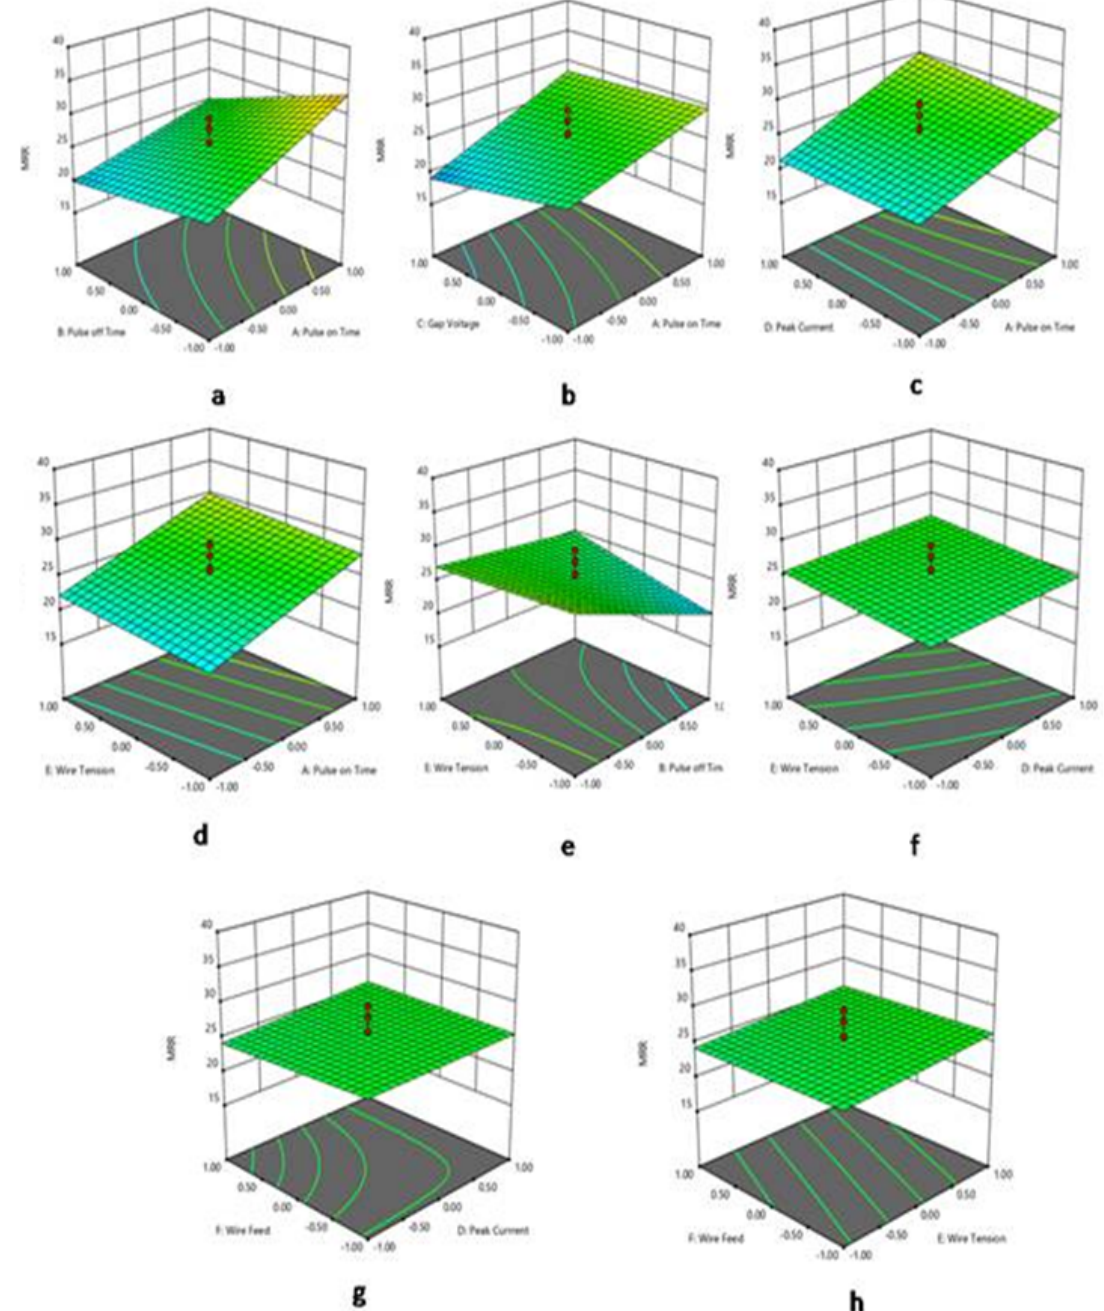
Figure 3: Three dimensional plot of combined effects of (a) pulse-on time and pulse-off time (b) pulse-on time and gap voltage (c) pulse-on time and peak current (d) pulse-on time and wire tension (e) pulse-off time and wire tension (f) and gap voltage and wire tension (g), peak current and wire tension (h), peak current and wire feed (i), wire tension and wire feed on MRR when other factors were kept